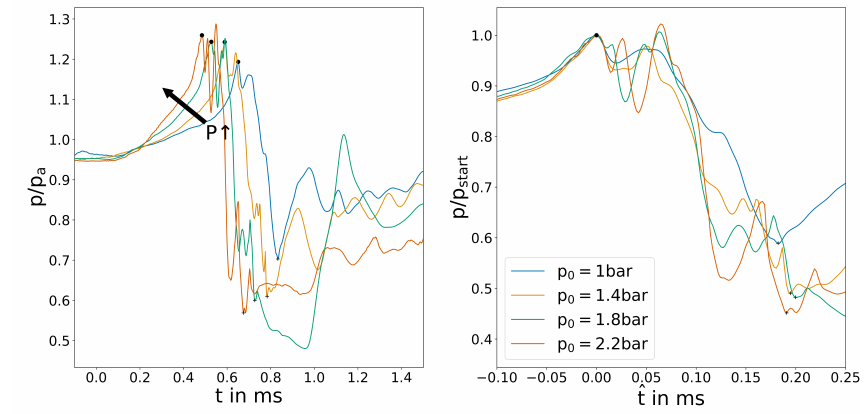
Figure 9. Averaged outlet channel pressure for the variation of tp .